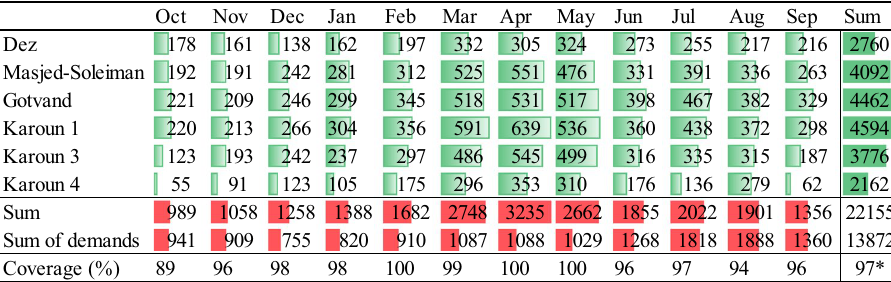
hydropower generation for scenario 2